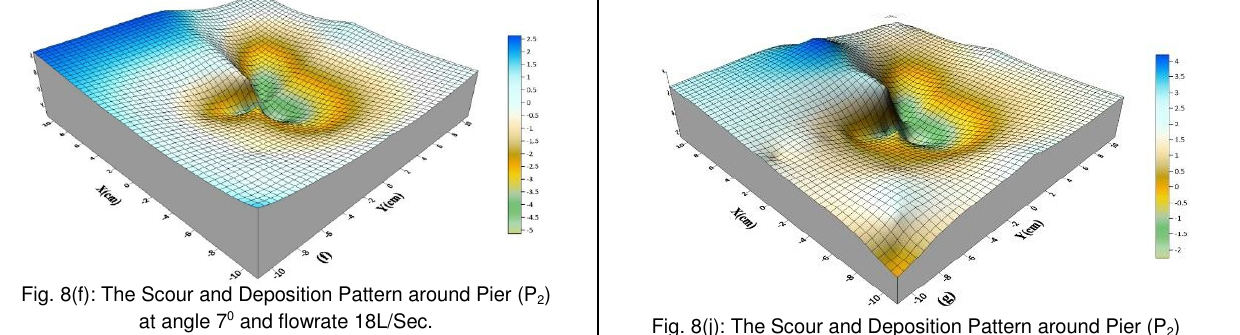
Fig. 8(j): The Scour and Deposition Pattern around Pier (P 2 ) at angle 15 0 and flowrate